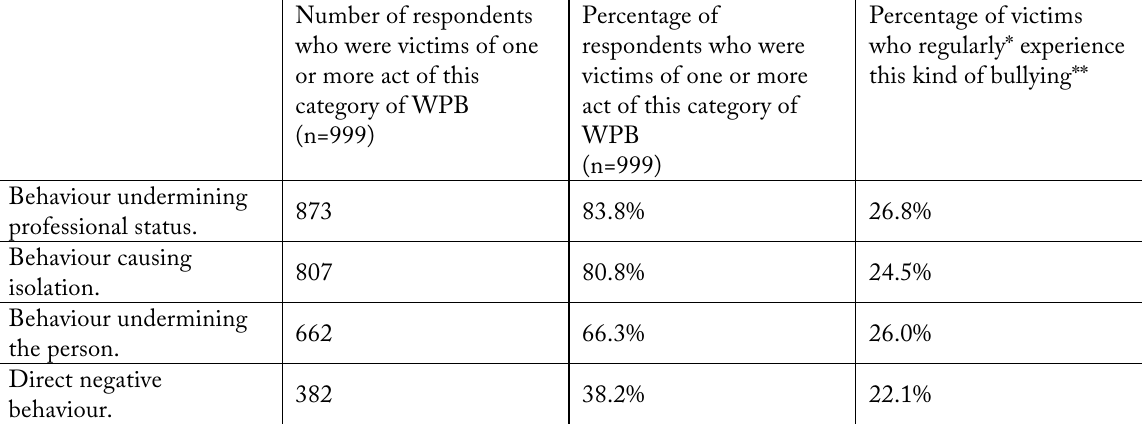
Table 1: Percentage of respondents who experienced different categories/types of WPB Number of respondents who were victims of one or more act of this